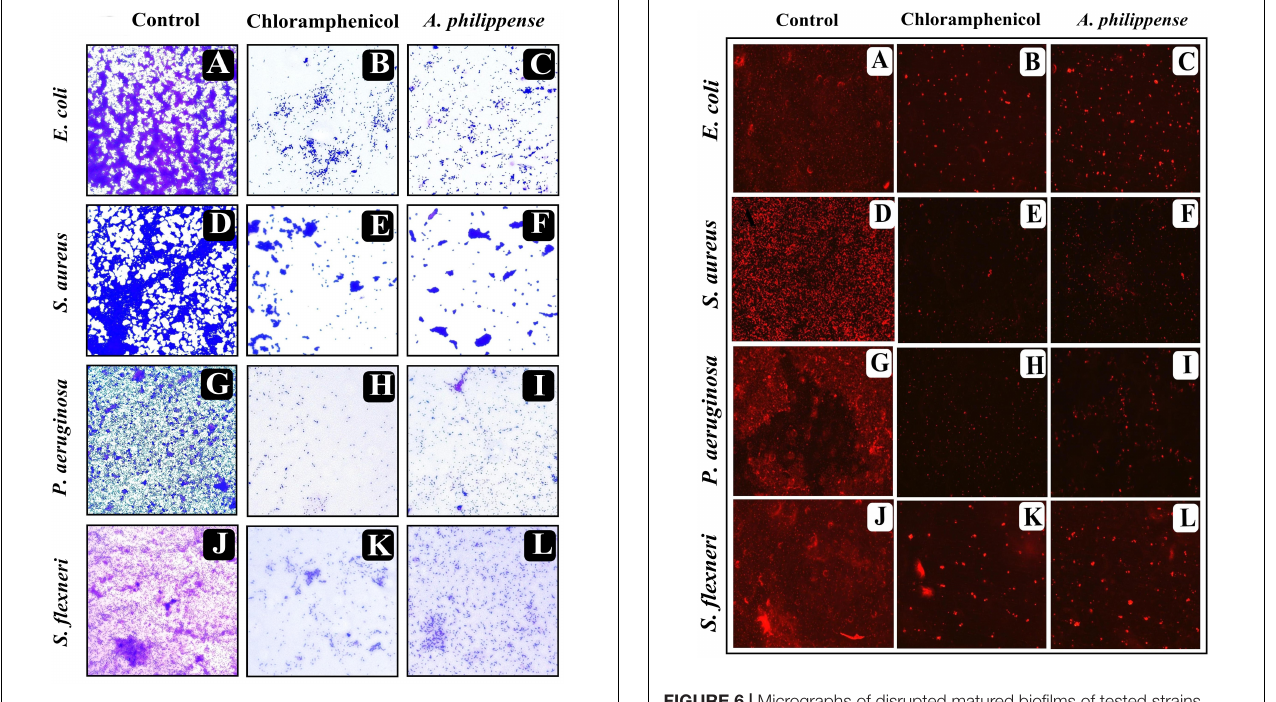
FIGURE 5 | Micrographs of disrupted matured biofilms of tested strains formed on glass surfaces by the A. philippense crude extract at their respective MICs by light microscopy (at 40x magnification). (A,D,G,J) Growth control; (B,E,H,K) Positive control chloramphenicol; and (C,F,I,L) A. philippense crude extract.